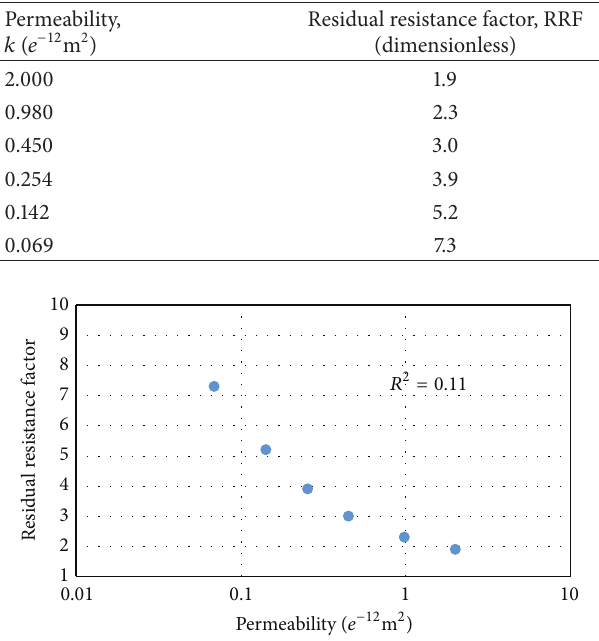
Figure 1: Residual resistance factors versus rock permeability, caused by polymer adsorption